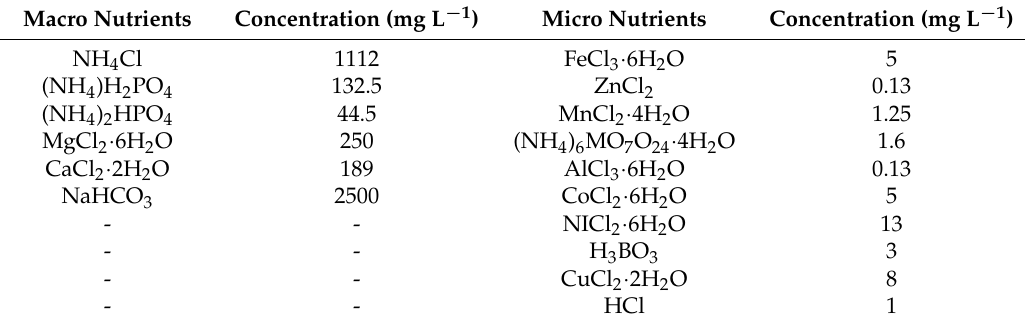
Table 9. The nutrient solution, micro- and macro-nutrients (adapted from Chernicharo 2007 [50], Aguilar-Aguilar et al., 2017 [9], Aquino et al., 2007 [51]) . Macro